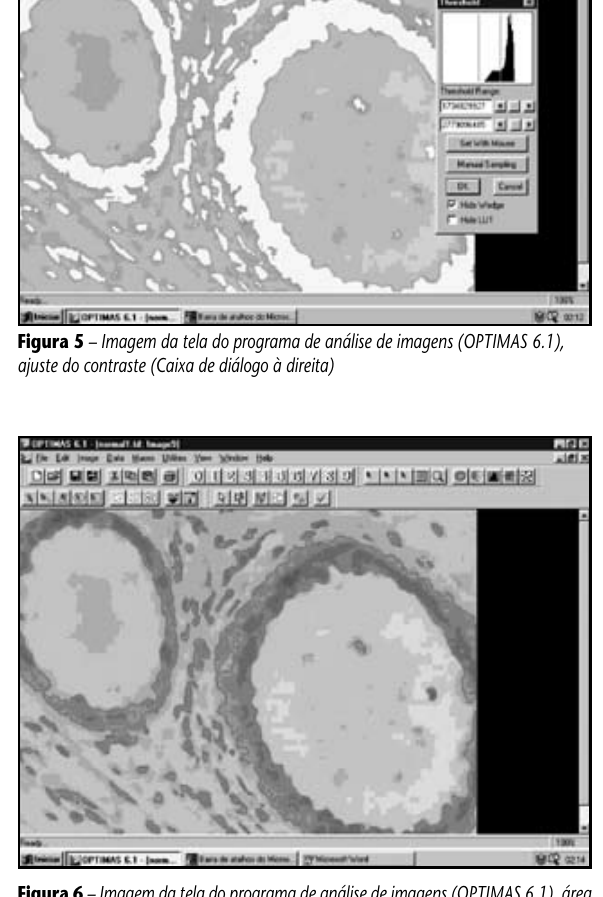
Figura 6 – Imagem da tela do programa de análise de imagens (OPTIMAS 6.1), área média de células marcadas (Áreas teciduais marcadas)